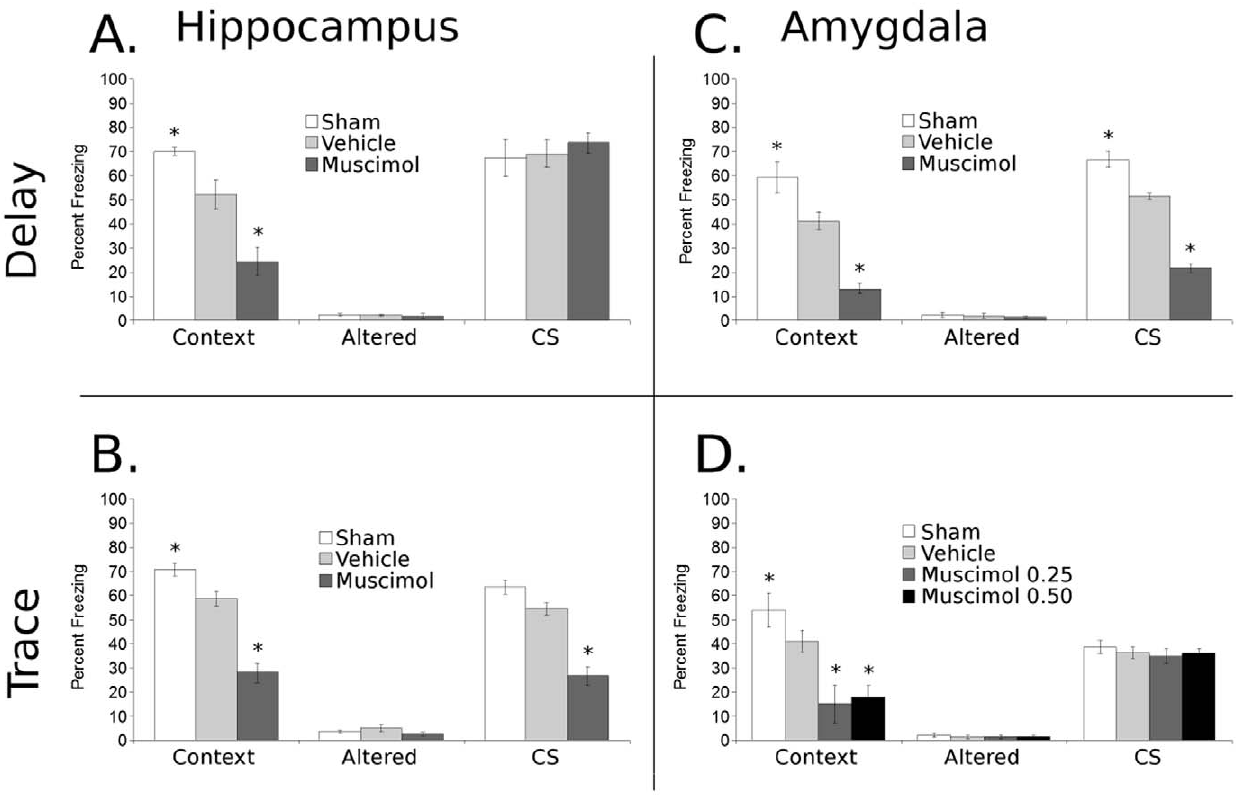
Figure 2. Effects of DH or amygdala inactivation on contextual and cued components of delay and trace fear conditioning. Infusion of muscimol into the DH disrupts acquisition/consolidation of trace ( B ) and contextual ( A & B ) but not delay conditioning ( B ), while muscimol infusion into the amygdala disrupts delay ( C ) and contextual ( C & D ), but not trace conditioning ( D ). These results suggest that the amygdala may be differently involved in trace conditioning than in contextual and delay conditioning. Additionally, deficits in vehicle compared to sham in contextual ( A, B, C & D ) and CS freezing ( B & C ) show that disruption of DH or amygdala can interfere with conditioning. Subjects per group from top to bottom by panel, were: ( A ) 4, 6, 6; ( B ) 4, 6, 6; ( C ) 8, 8, 8; ( D ) 7, 14, 6, 12. Data represented as Mean 6 SEM, * denotes significant difference from vehicle control group.